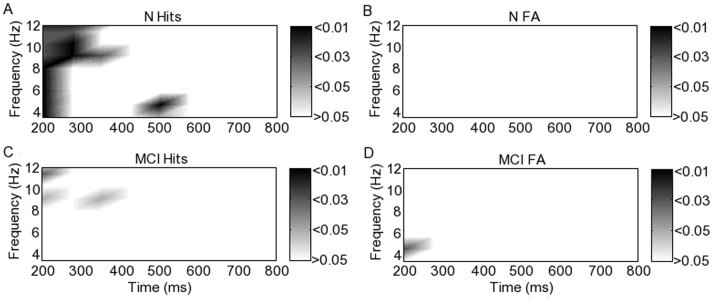
Fronto-parietal correlation between levels of phase locking calculated using empirical mode decomposition phase locking analysis.p-values corrected for multiple comparisons are shown in greyscale for typical and mildly cognitively impaired groups during hits and false alarms.